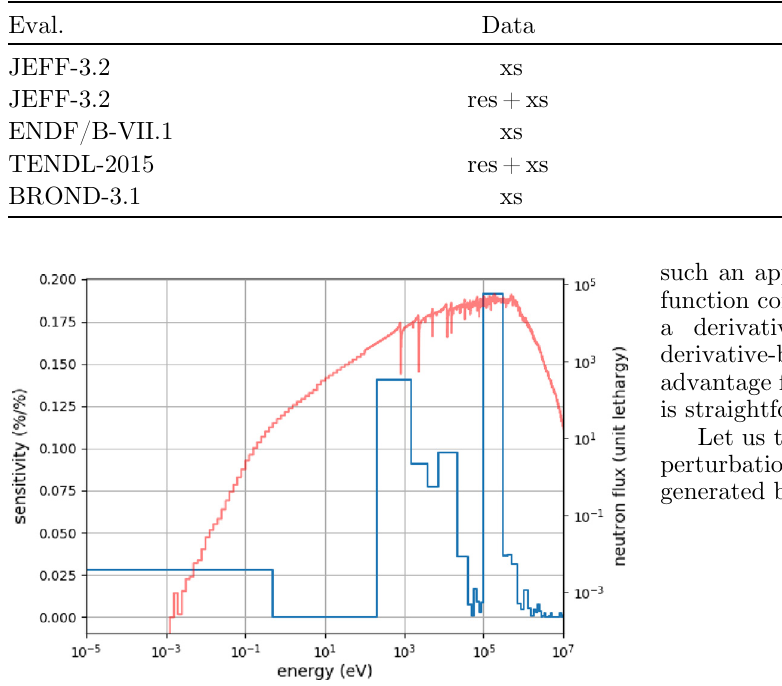
Table 3. Nuclear data uncertainty contribution to the 210 Po production and the integrated fl ux. Eval.